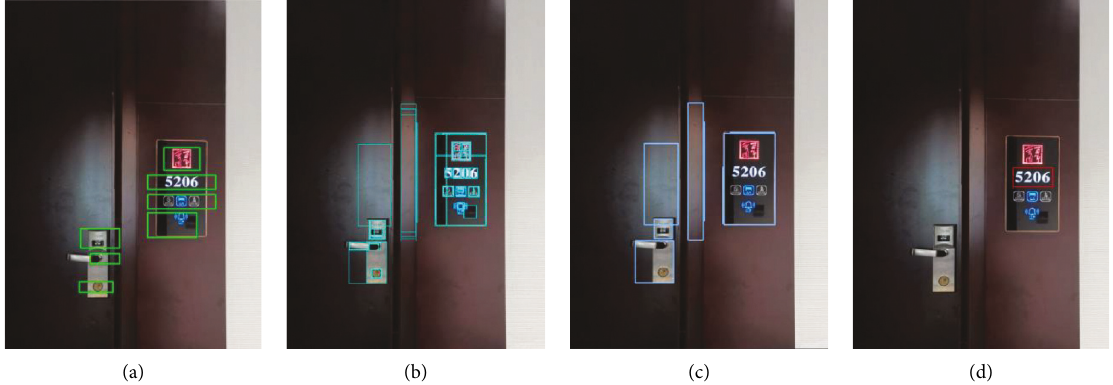
Figure 6: Text detection results. (a) Morphological method; (b) MSER; (c) MSER and NMS; (d) deep